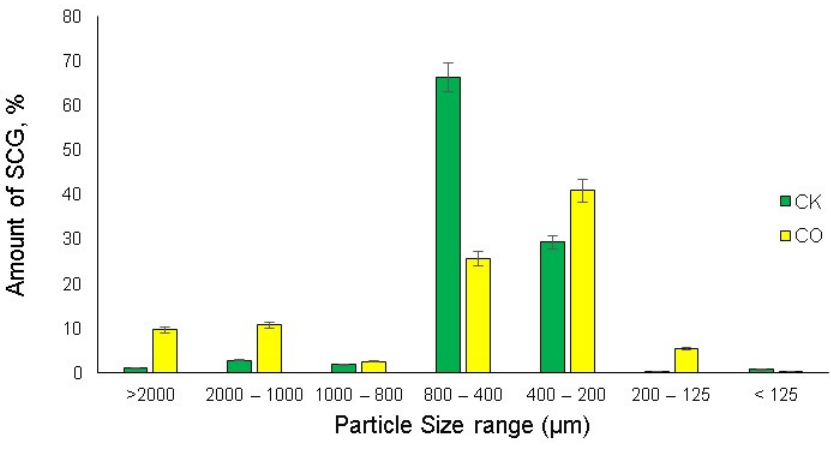
Figure 2. Particle size distribution of CK and CO spent coffee grounds ( n = 3, error bars indicate SD).